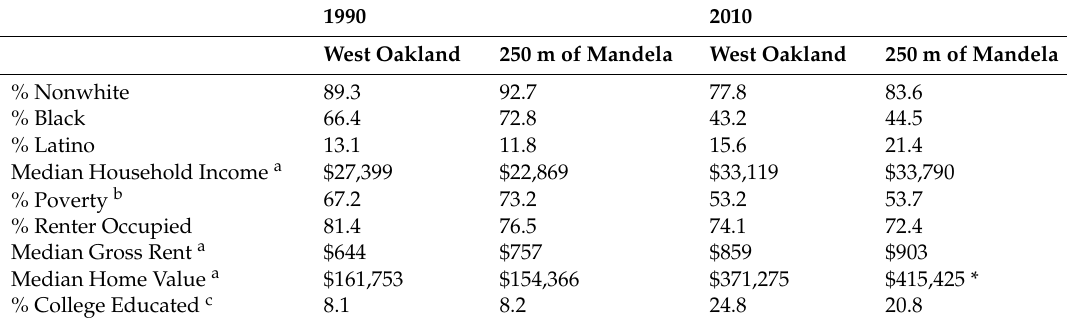
Table 1. Comparison of racial and socioeconomic composition for all tracts in West Oakland, and within 250 m of the Mandela Parkway alignment in 1990 and 2010.